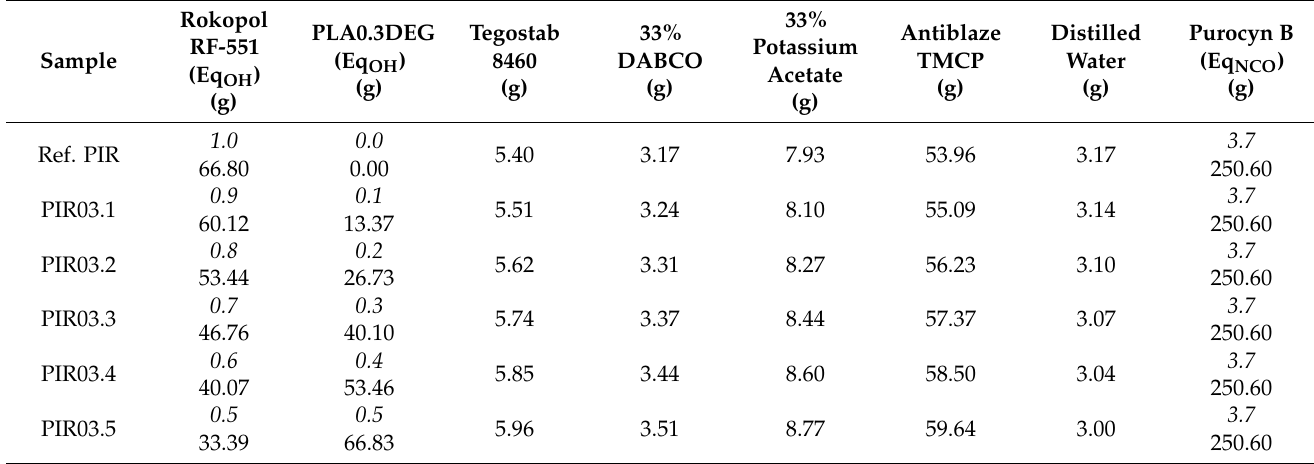
Table 11. Formulation of RPU/PIR foams with PLA0.3DEG